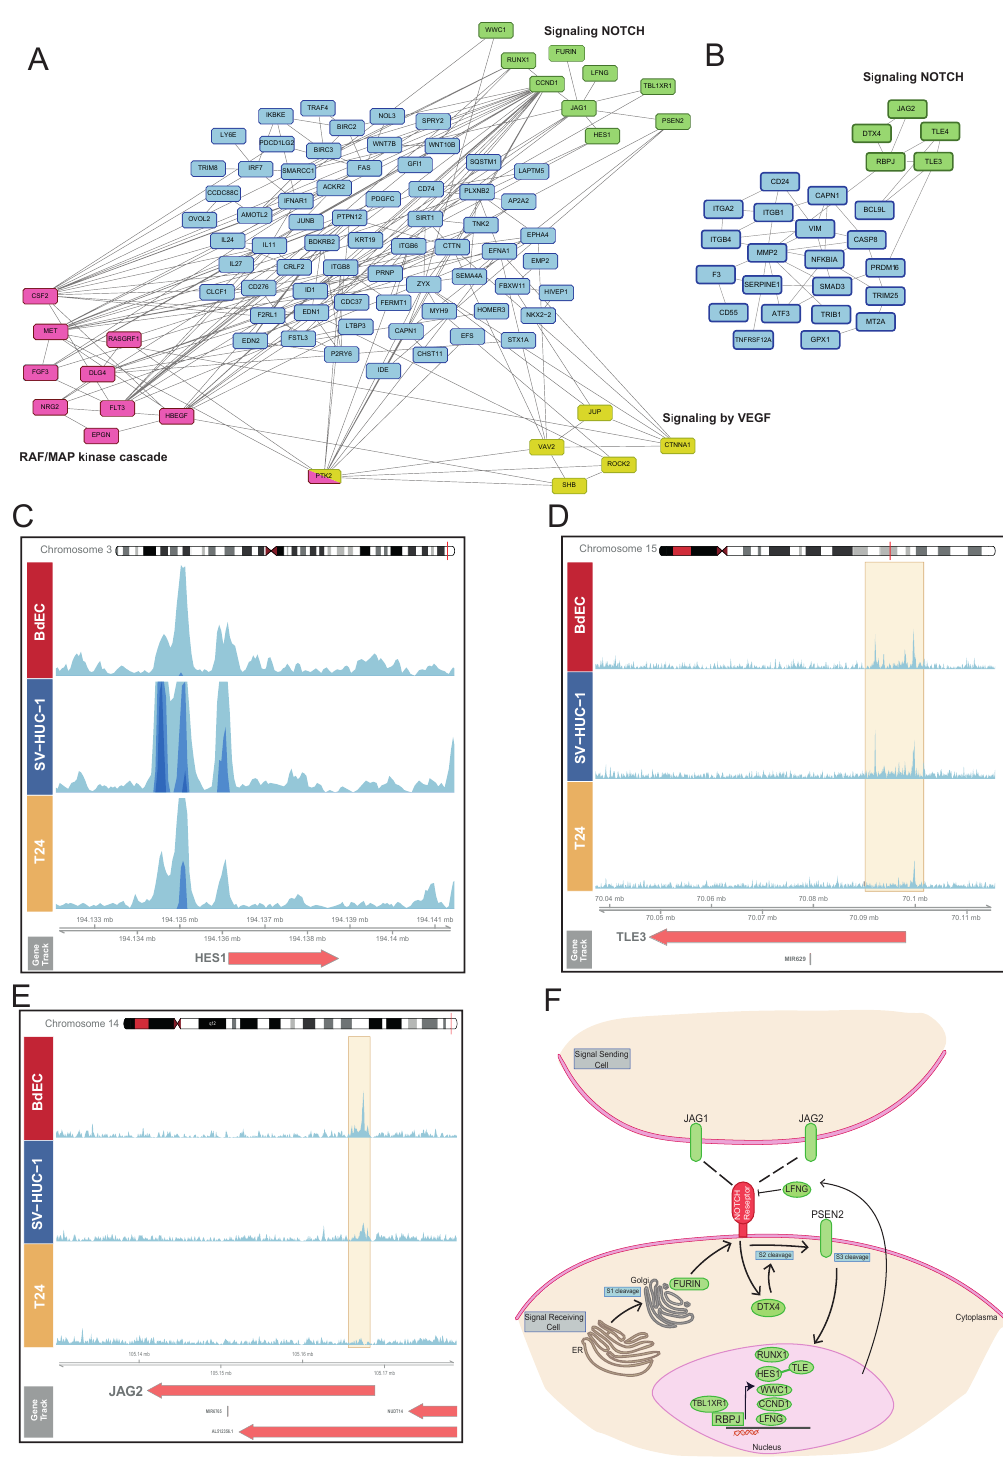
Figure 3. Genes regulated by KDM6A are implicated in notch signaling. ( A , B ) Analysis of the genes involved in cell surface receptor signaling for IH-MULTI ( A ) and normal-immortal clusters ( B ). Interaction data obtained from String was visualized using Cytoscape. ( C – E ) Snapshot images showing KDM6A signal in BdEC, SV-HUC-1, and T24 cell lines at HES1 ( C ), TLE3 ( D ), and JAG2 ( E ) loci. ( F ) Manually created cartoon showing the genes involved in Notch signaling and associated with KDM6A peaks ( A , B ). Genes marked with KDM6A signal are highlighted in